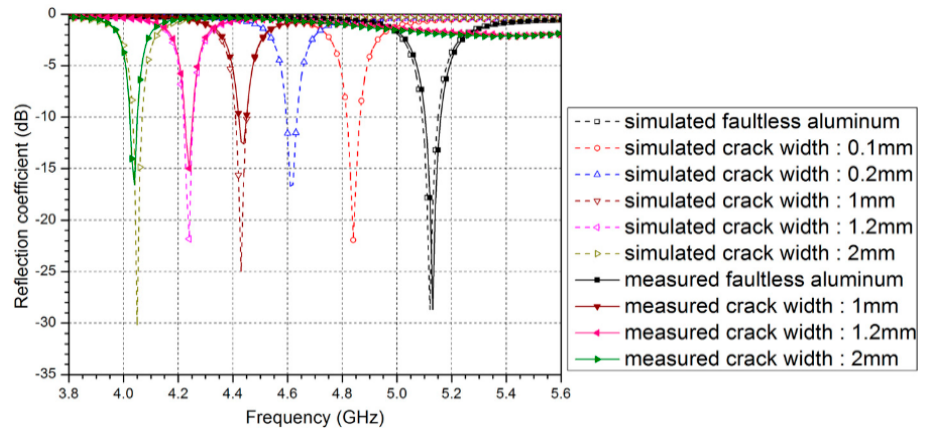
Figure 31. Simulated and measured results of the reflection coefficient for a crack depth of 1 mm (from [41]; copyright © 2014; reproduced with permission).